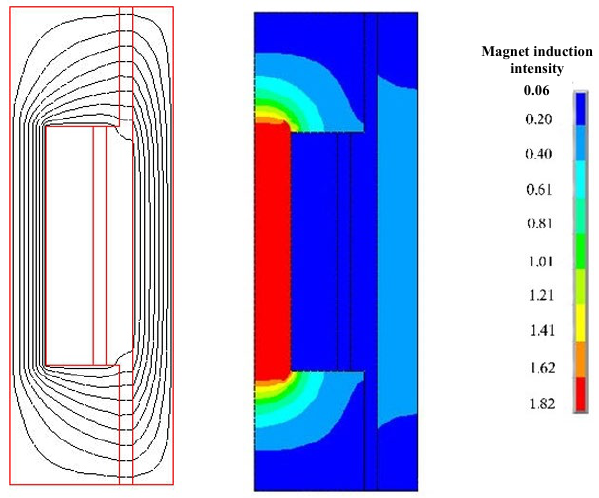
Figure 6. The vector diagram and the nephogram of the magnetic induction intensities of a single-coil MR damper with the excitation current of 2.0 A.